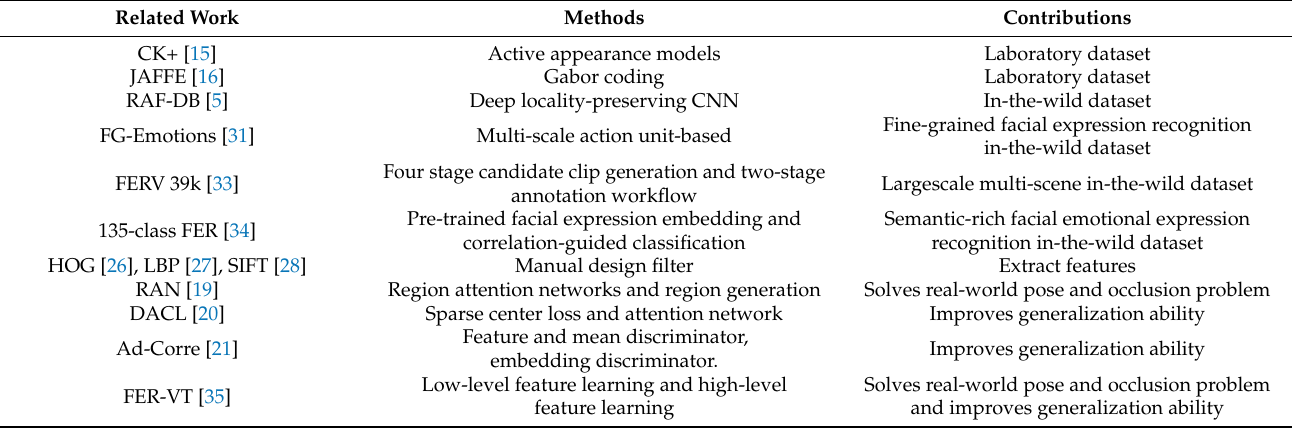
Table 1. Summary of related